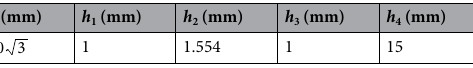
Table 1. The parameters of the unit cell.